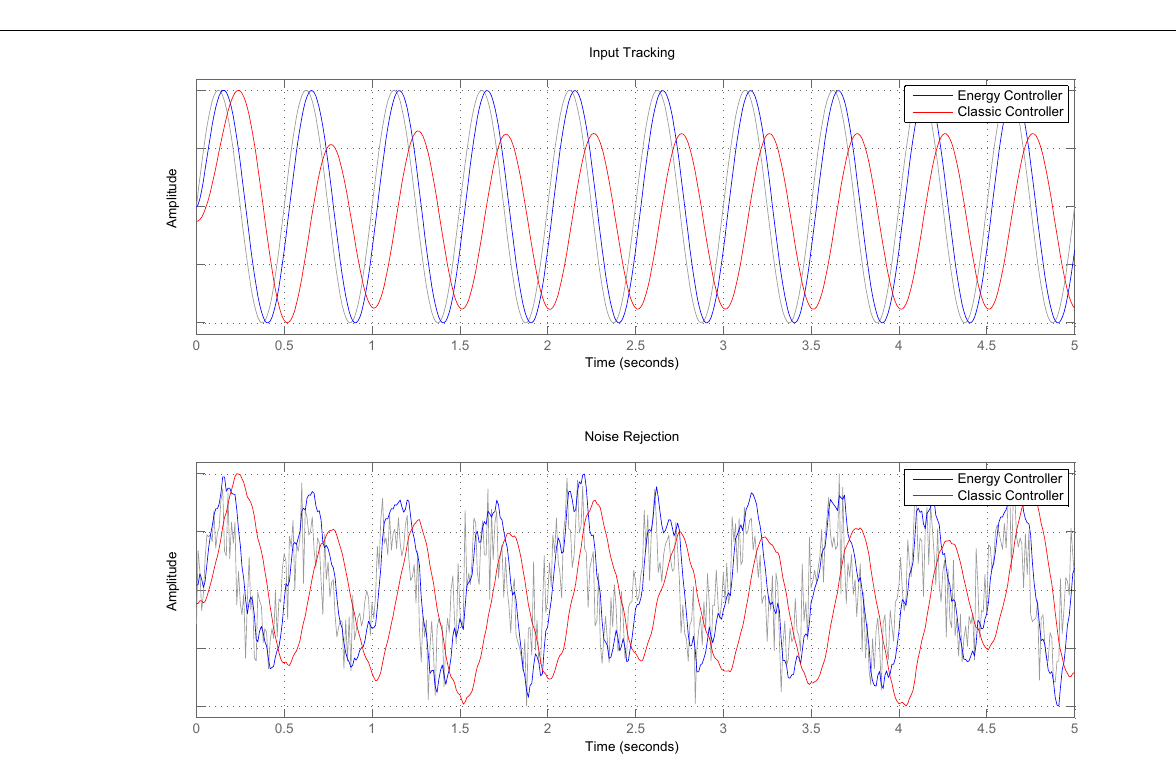
FIGURE 7 | Reference input tracking comparison between the novel energy-based controller and a classical PD + gravity controller .